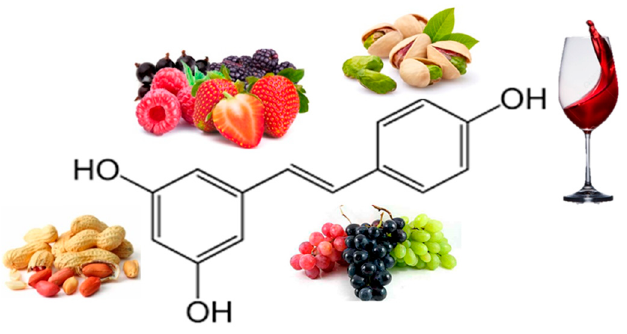
Figure 6. Chemical structure and major sources of resveratrol. Table 1. Anti-obesity actions of curcumin, quercetin, and resveratrol.